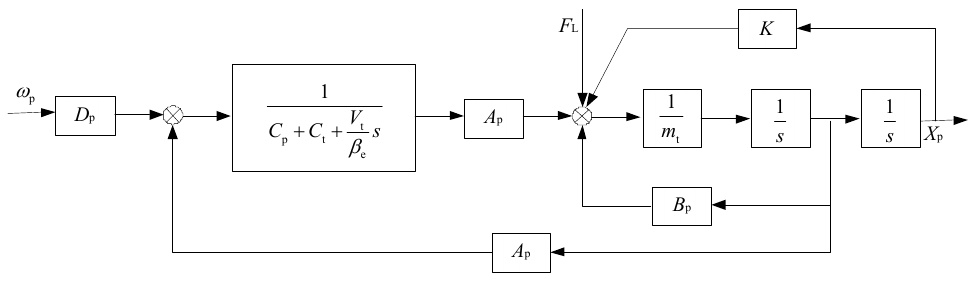
Figure 4. Block diagram of position control for the PCSM.